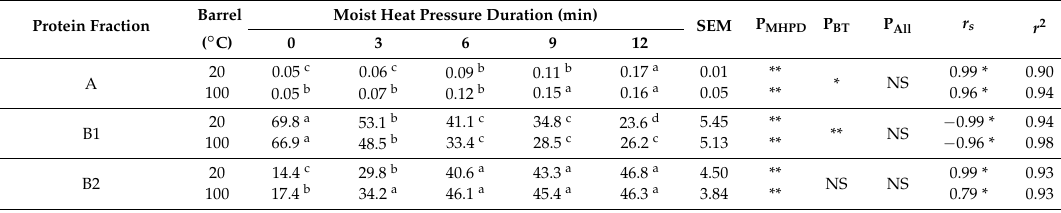
Table 2. Cornell Net Carbohydrate and Protein System protein fractions of cold-pressed (20 ◦ C)